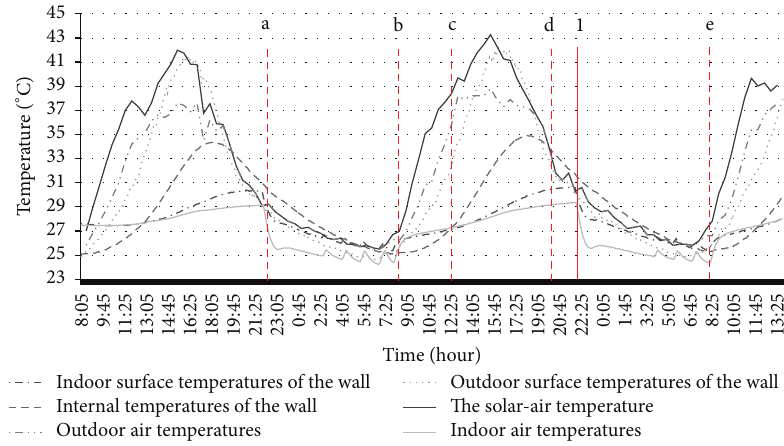
Figure 4: Testing-point temperatures of externally insulated wall in night time running state of